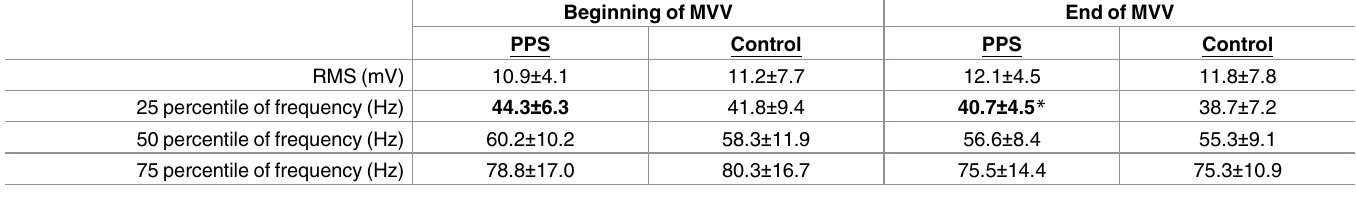
Table 4. Root mean square (RMS) and frequency quartiles (25, 50, and 75) 0f the electromyography (EMG) signal acquired during Maximal Volun- tary Ventilation (MVV) in the Post Polio Syndrome (PPS) group and the control group. Values are presented as mean ±